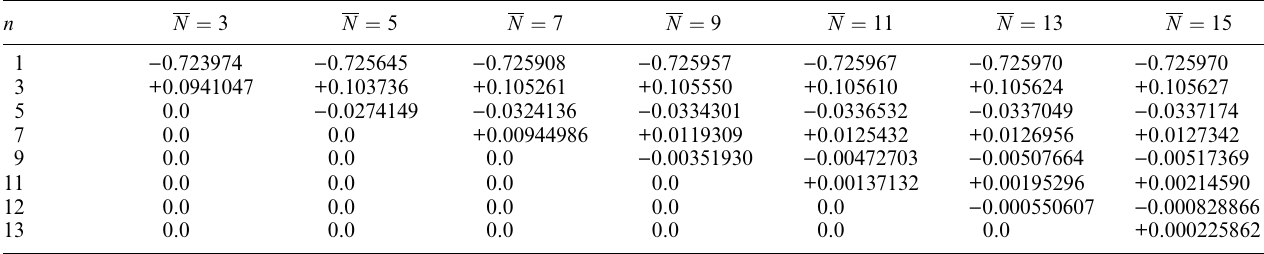
g 0 for selected values of n = 1